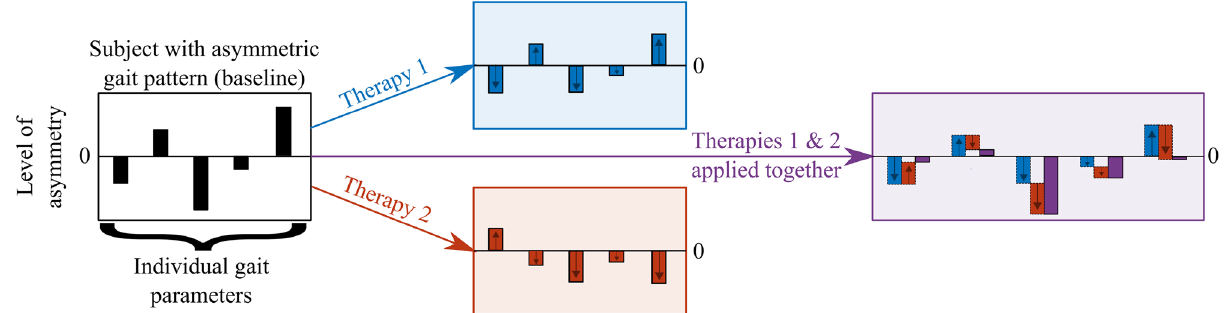
Figure 1. Predicted model of gait behavior under external stimuli. Black rectangle indicates different gait parameters level of asymmetry. Blue and red shaded backgrounds indicate effects from two rehabilitation therapies applied separately. Purple rectangle on the right is the hypothetical behavior of gait under multiple- rehabilitation therapy with therapies 1 and 2 applied simultaneously. Arrows indicate direction of asymmetric